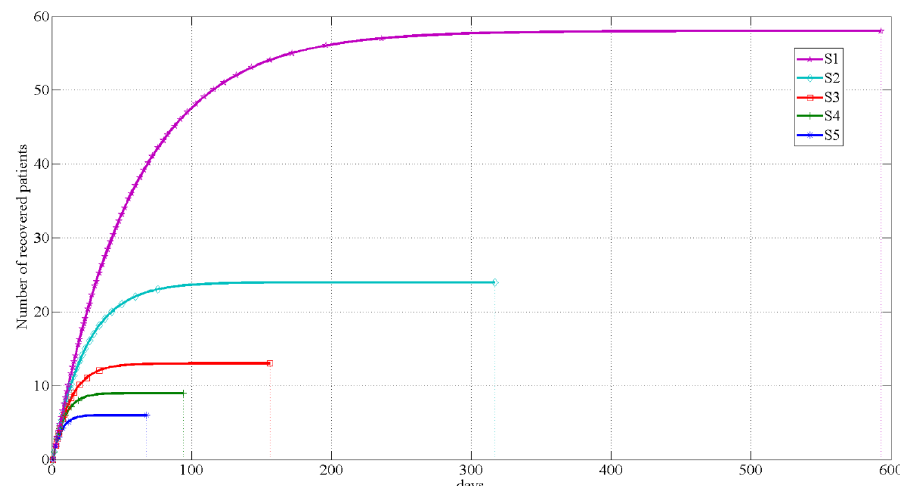
Figure 4. Changes in the number of patients recovered from strategies 1 – 5.